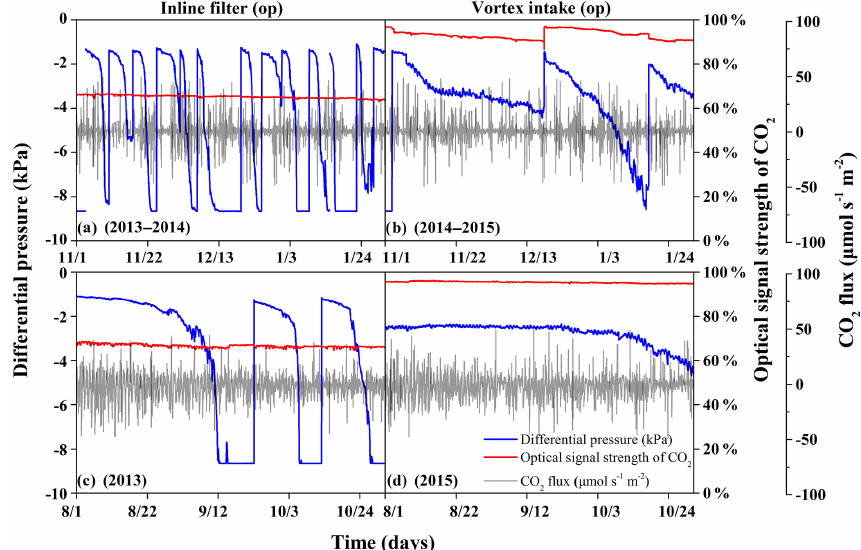
Figure 5. Differential pressure (blue line), optical signal strength of CO 2 (red line) and CO 2 flux (gray line) of the EC system (EC155) equipped with vortex intake as compared to an inline filter at the Olympic Park (op); panels (a) and (b) are for periods of very hazy conditions, whereas panels (c) and (d) are for periods of low